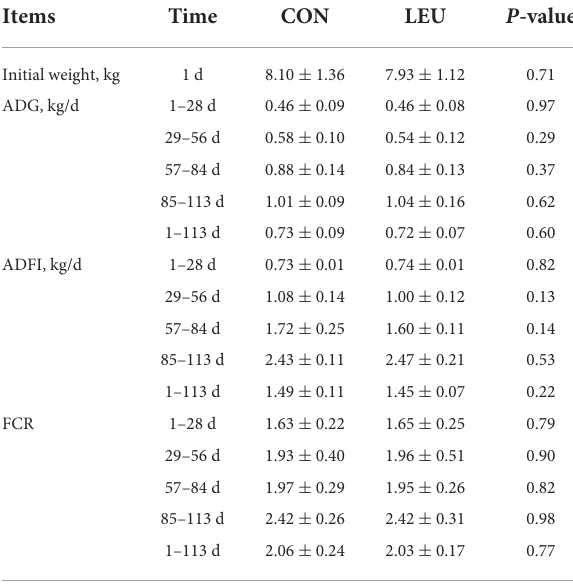
TABLE 1 Effect of dietary leucine supplementation on growth performance of boars.